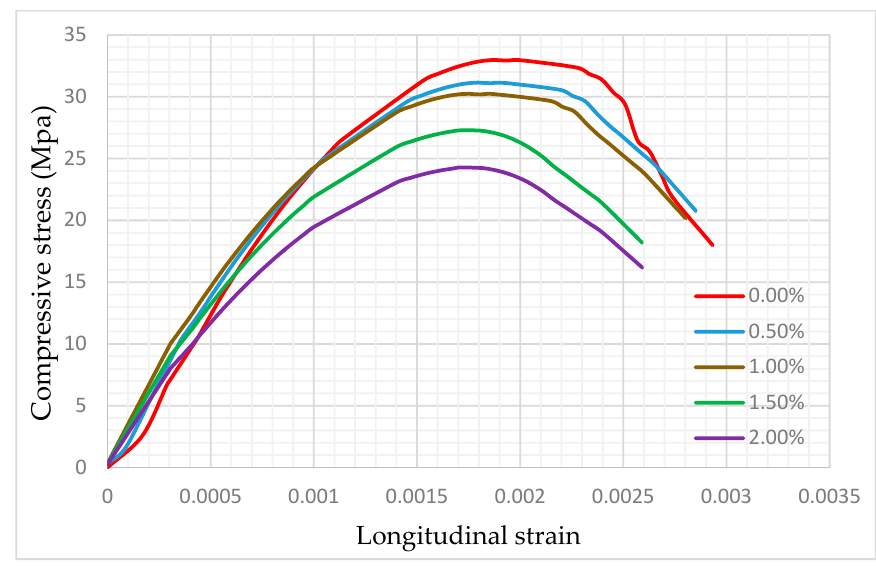
Figure 8. Compressive stress and longitudinal strain of concrete.